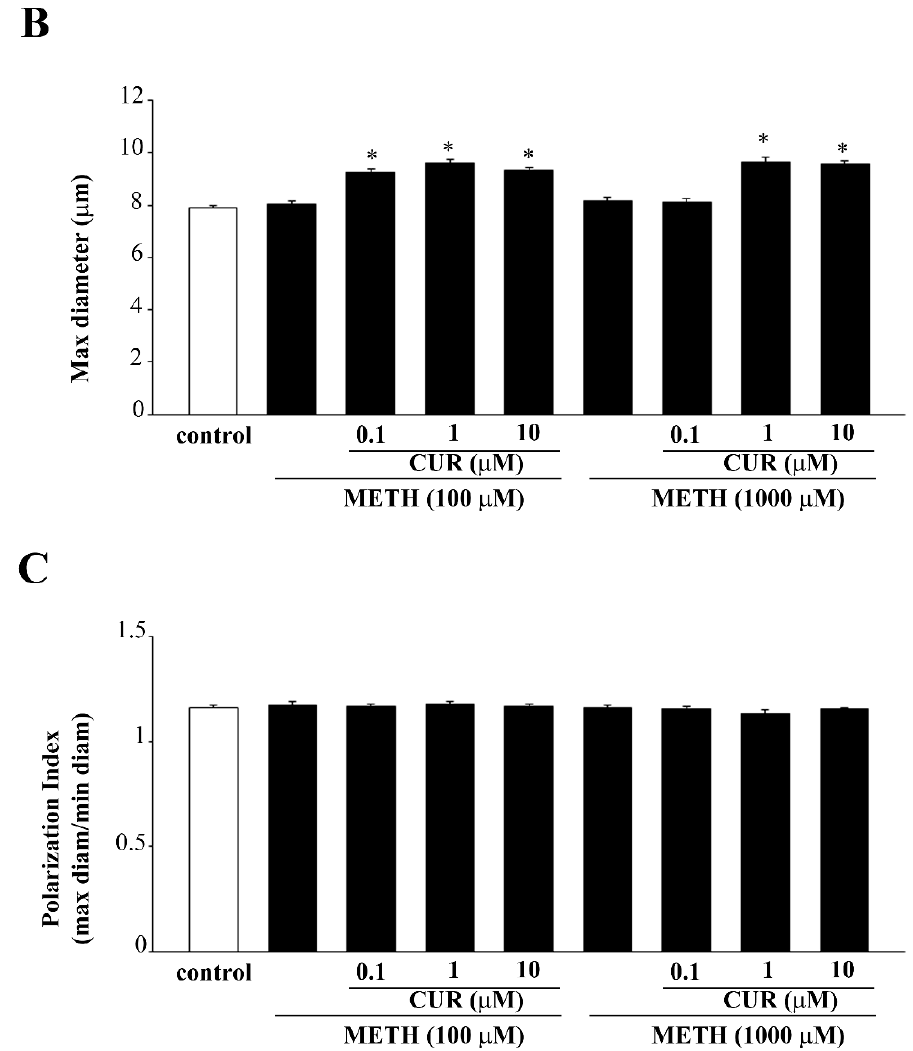
Figure 12. CUR prevents METH-induced morphological alterations. ( A ) Representative pictures of H&E-stained PC12 cells after various treatments. Cytosolic vacuoles occurs in METH-treated cells (arrows). ( B ) Maximum cell diameter and ( C ) Polarization index are reported. * p < 0.05 compared with control. Scale bar = 19.5 μ M.